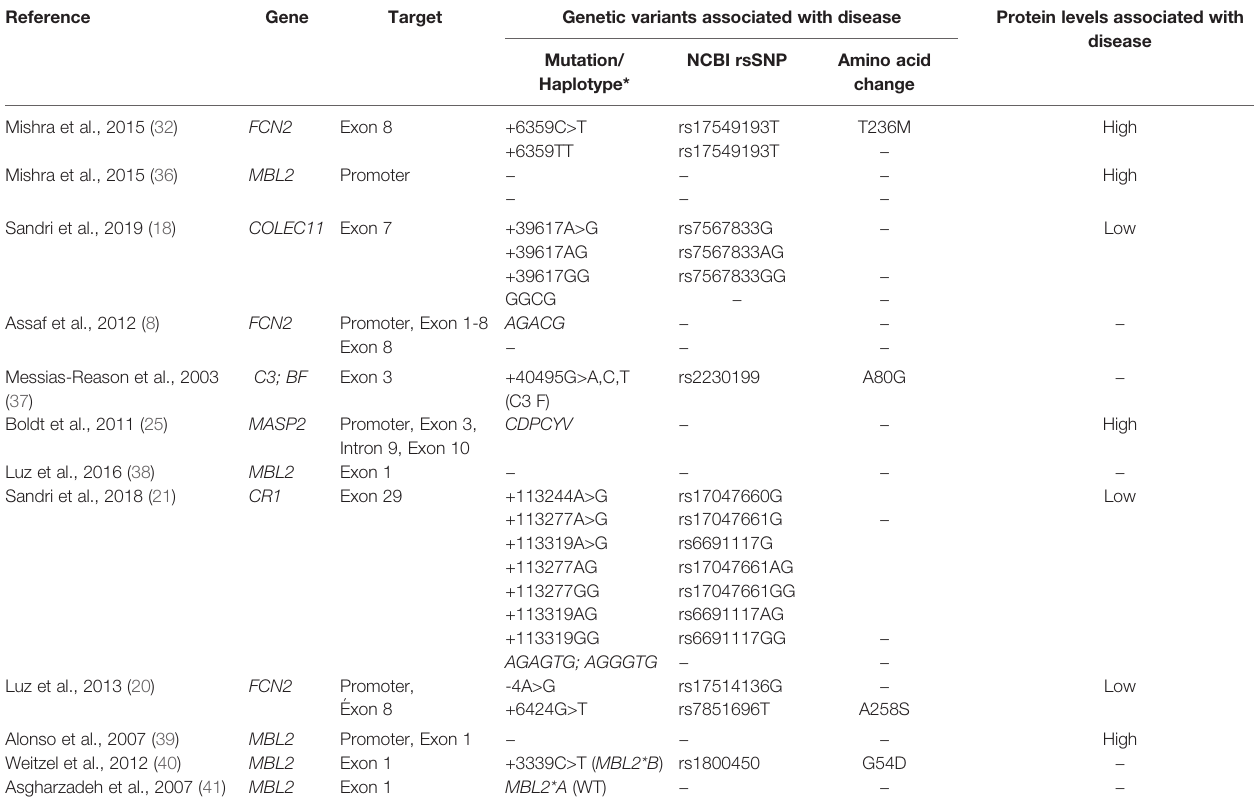
TABLE 2 | Main gene and protein alterations associated with disease progression found by articles included in this systematic